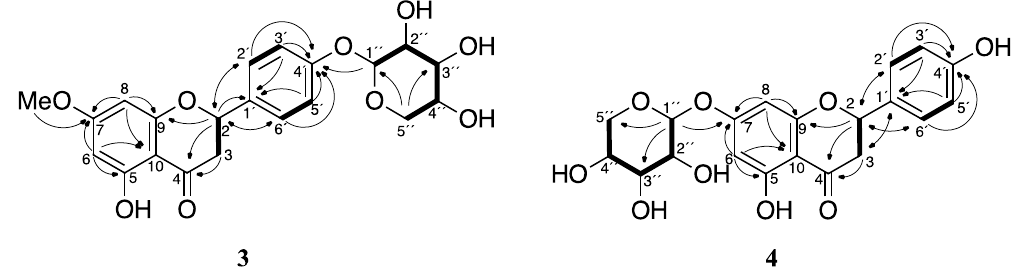
Figure 5. Key 2D NMR correlations for compounds 3 and 4 . The COSY and TOCSY correlations are represented by bold lines, and the HMBC are represented by arrows from H to C.